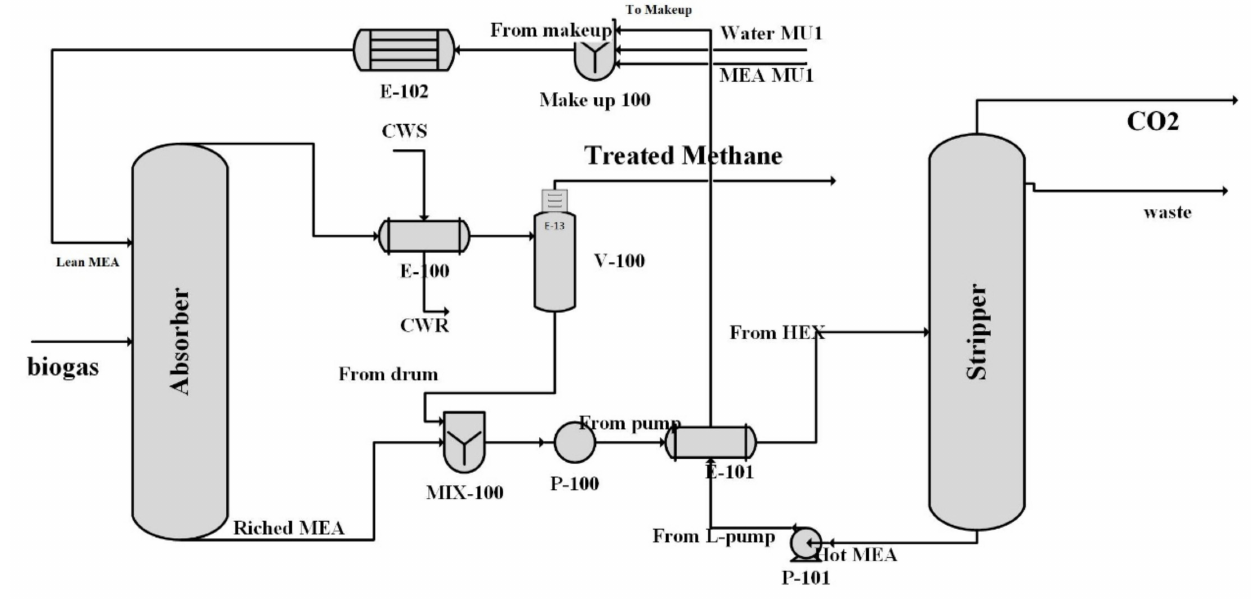
Figure 6. Process flow diagram of chemical scrubbing biogas